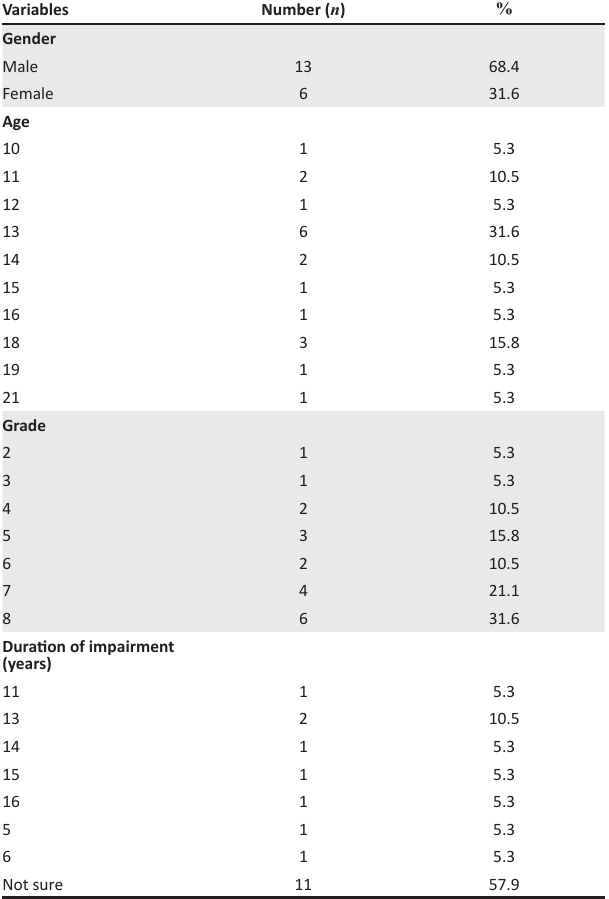
TABLE 1: The demographics of children with low vision in inclusive schools. Variables